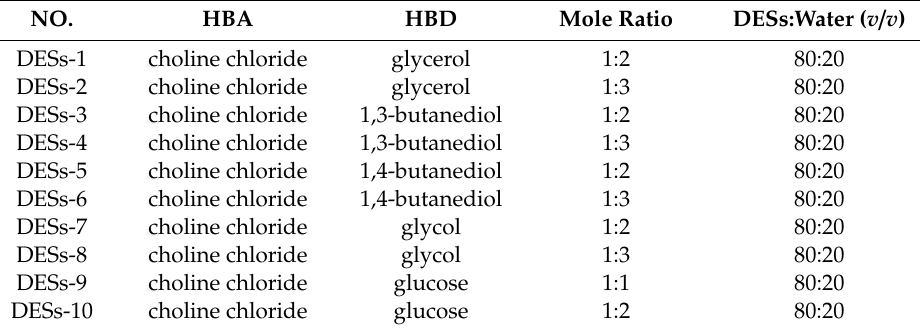
Table 1. Di ff erent types of deep eutectic solvents